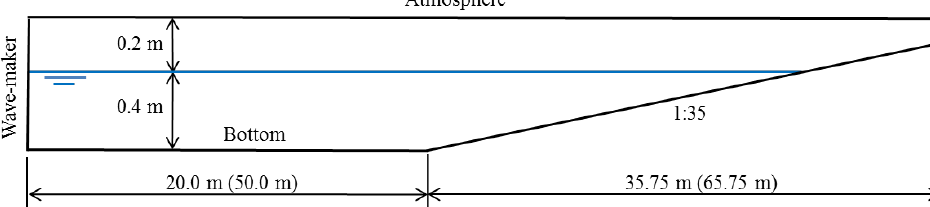
Figure 7. Sketch of the computational domain of Ting and Kirby [6] cases. Dimensions in parenthesis represent the plunging case.